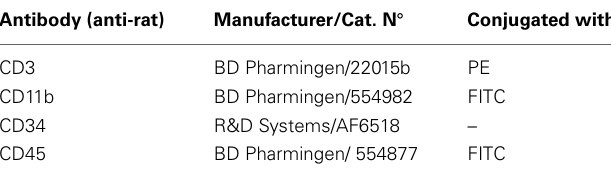
Table 2 | Antibodies used for flow